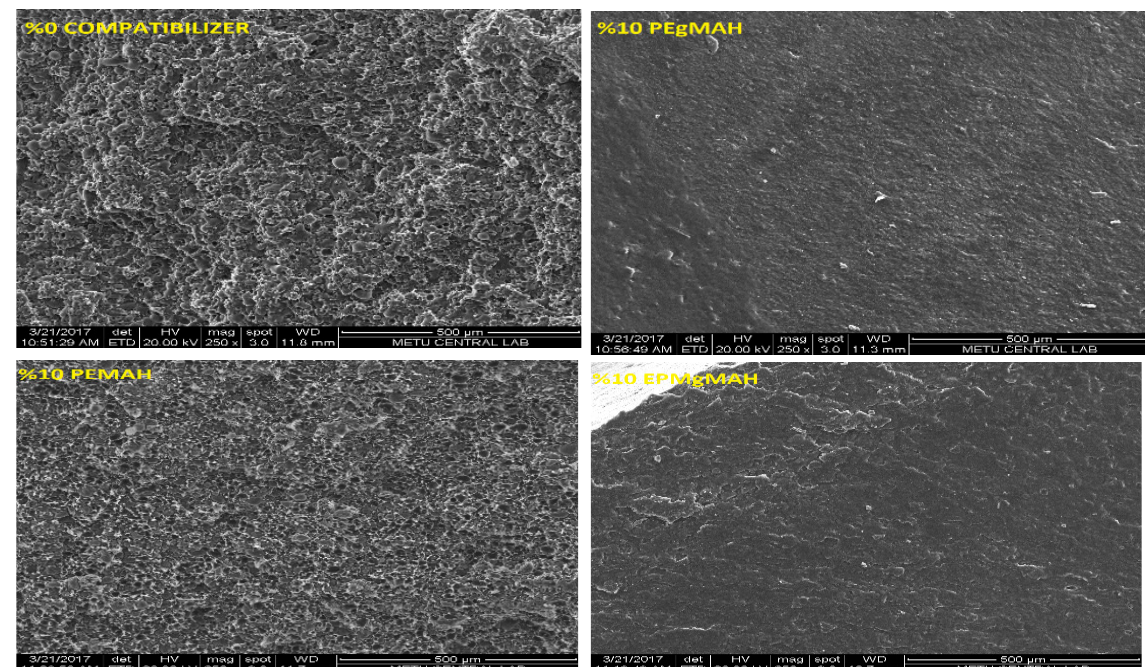
Figure 5: SEM Photographs of prepared r-LDPE/TPS based